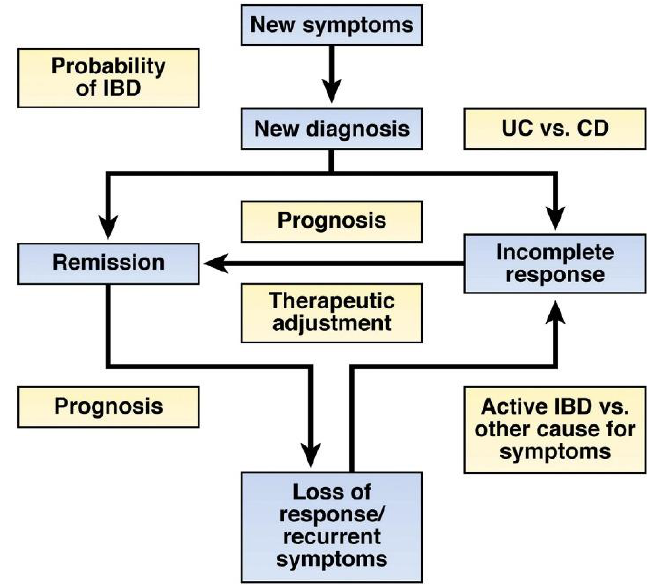
Figure 1. The potential role of biomarker assays in the care of patients with suspected or established IBD: Biomarkers may be used in all phases of the care. For patients with suspected IBD, biomarkers can be used to select which patients are unlikely to have IBD and could forgo further testing. Once patients are diagnosed, biomarkers can determine which patients have CD or UC and predict the disease course. Biomarkers can be used to determine which patients are most likely to respond to therapies, determine prognosis, and identify those who require more aggressive therapies. In patients with recurrent symptoms, biomarkers can differentiate patients with active inflammation from those likely to have symptoms from other causes. Adapted from James D. Lewis’s review [23]; Gastroenterology , Volume 140 Issue 6, Pages 1817–1826.e2;